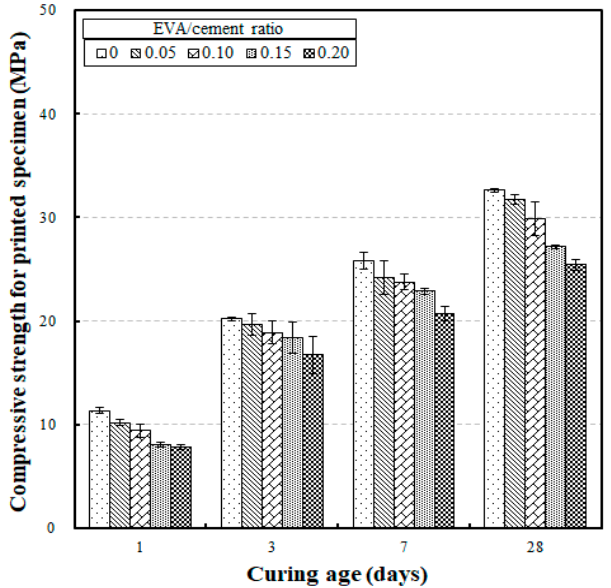
Figure 4. Compressive strength for printed specimens versus curing age with different EVA/cement ratios.